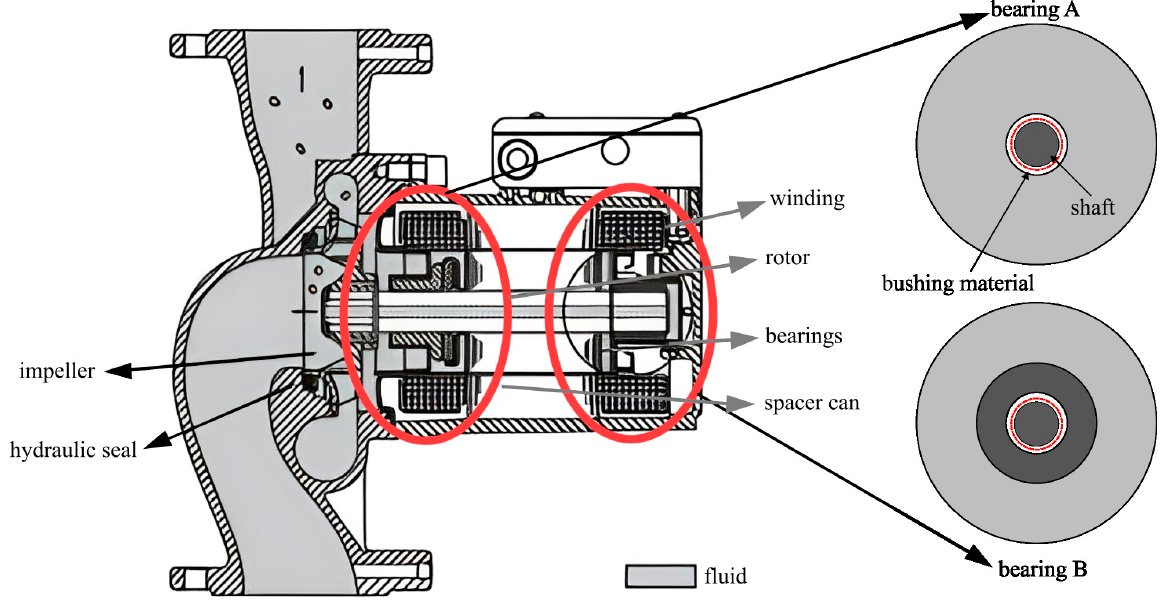
Figure 4. Pump diagram [134] and description of the utilized journal bearing including degradation description.